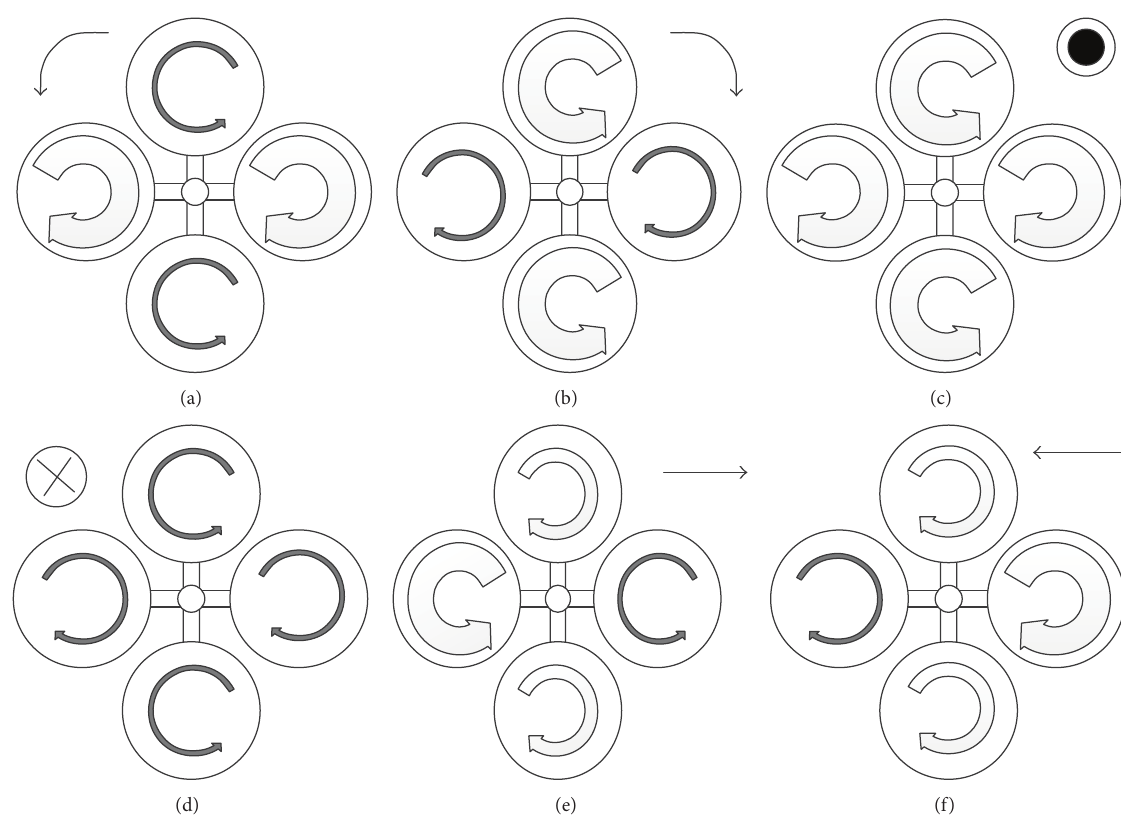
Figure 2: Quadrotor dynamics: (a) and (b) difference in torque to manipulate the yaw angle ( Ψ ); (c) and (d) hovering motion and vertical propulsion due to balanced torques; (e) and (f) difference in thrust to manipulate the pitch angle ( 𝜃 ) and the roll angle ( 𝜙 ).